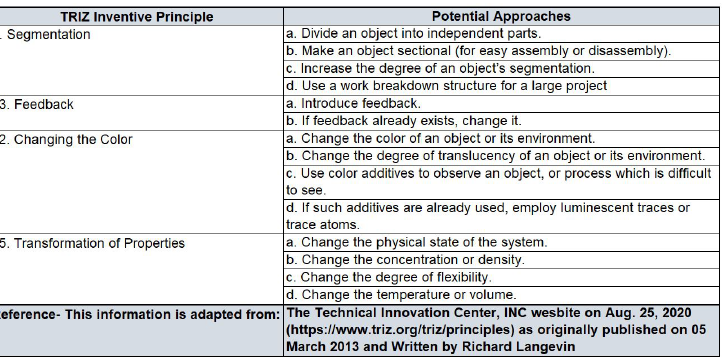
Figure 15. TRIZ Inventive Principles with Details to Address Technical Requirements Conflict